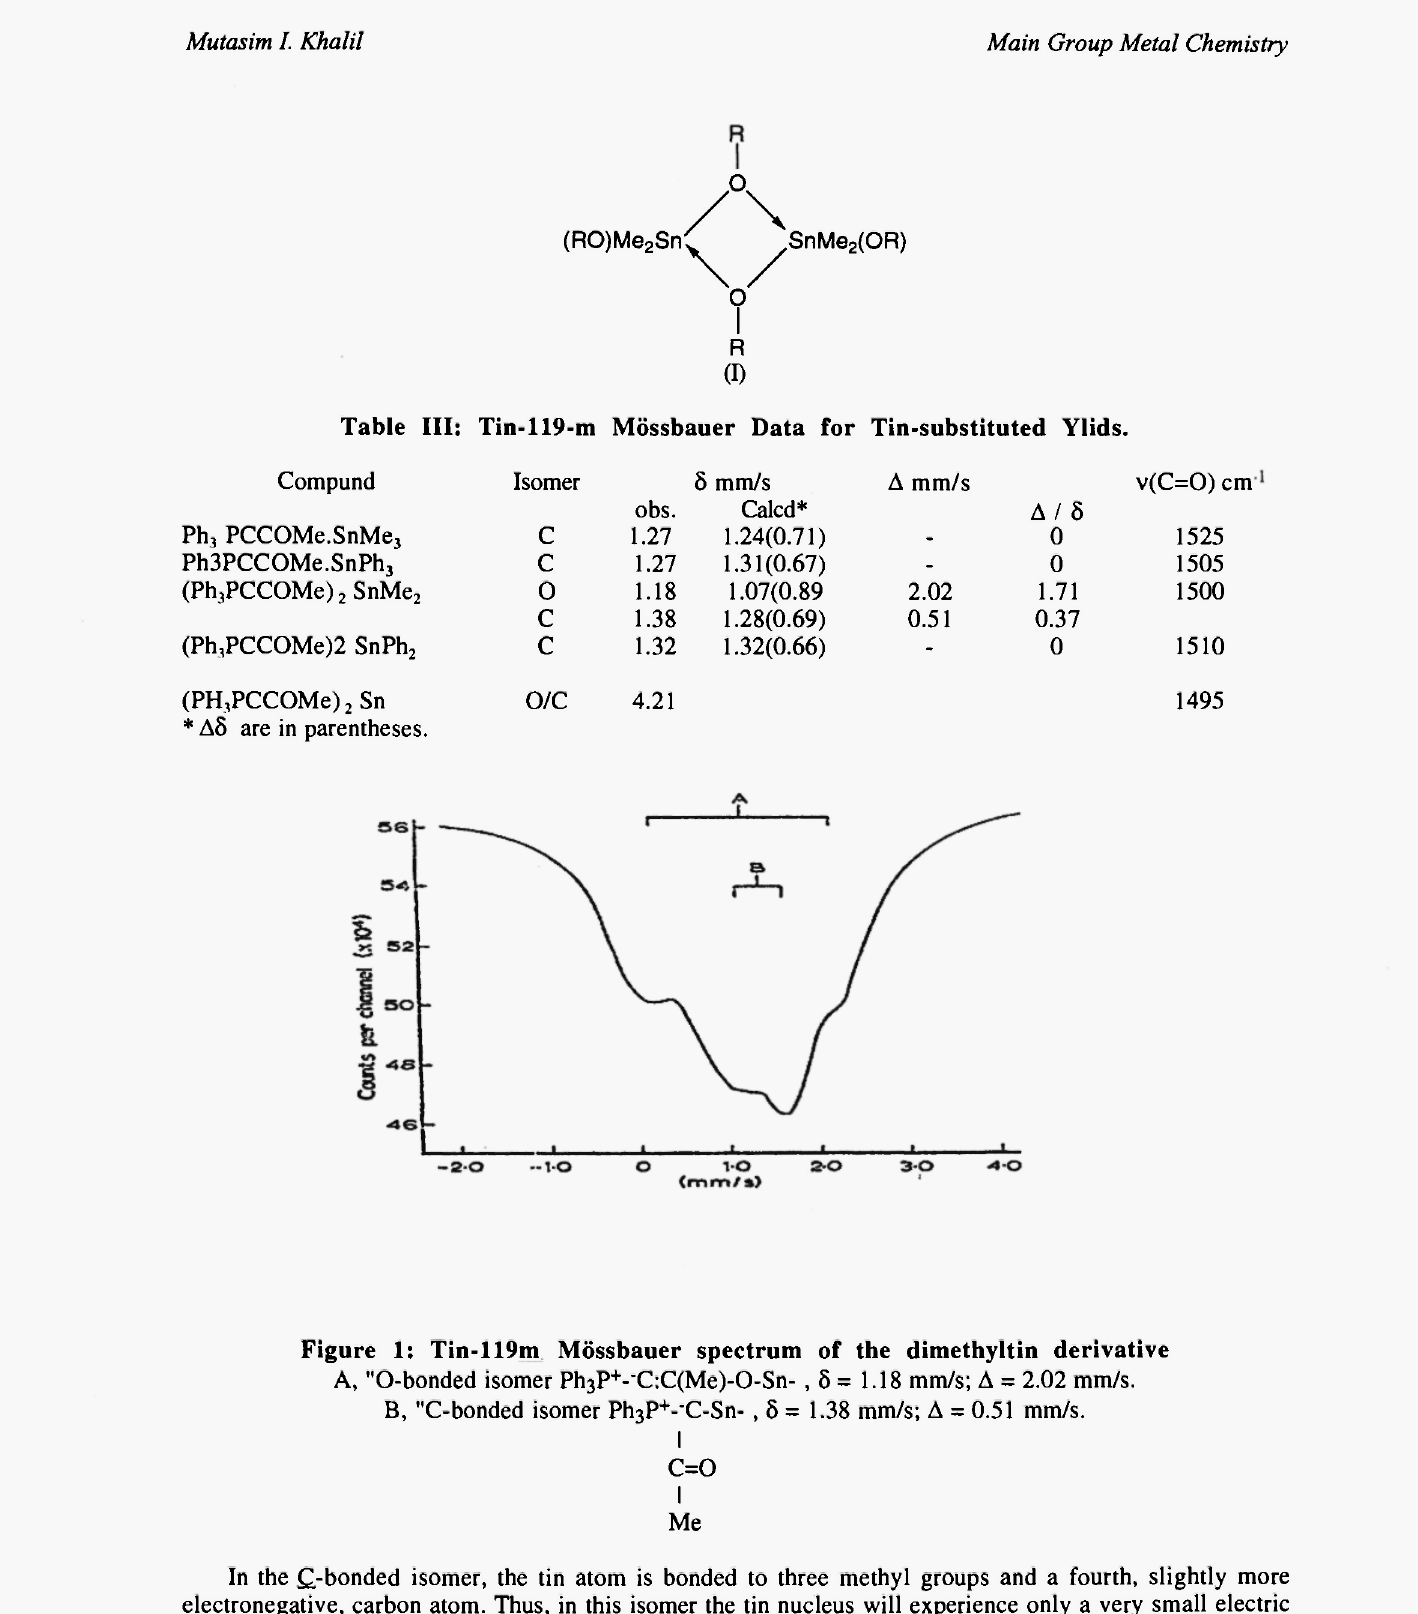
Table III: Tin-119-m Mössbauer Data for Tin-substituted Ylids.